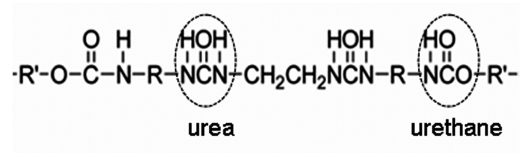
Figure 1. Urethane/urea group in polyurethane (PU). Figure 1. Urethane / urea group in polyurethane